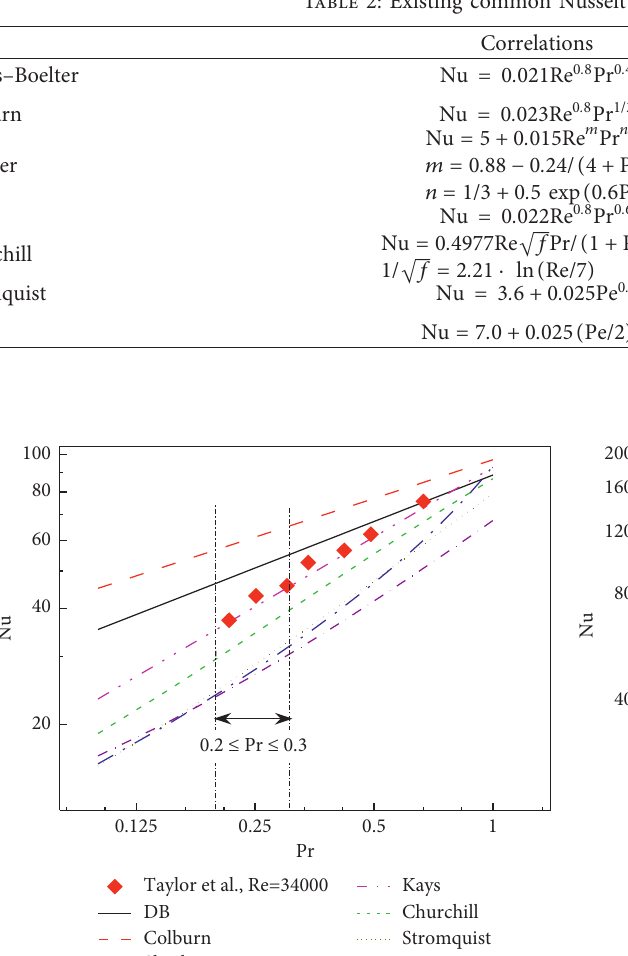
Table 2: Existing common Nusselt number correlations.